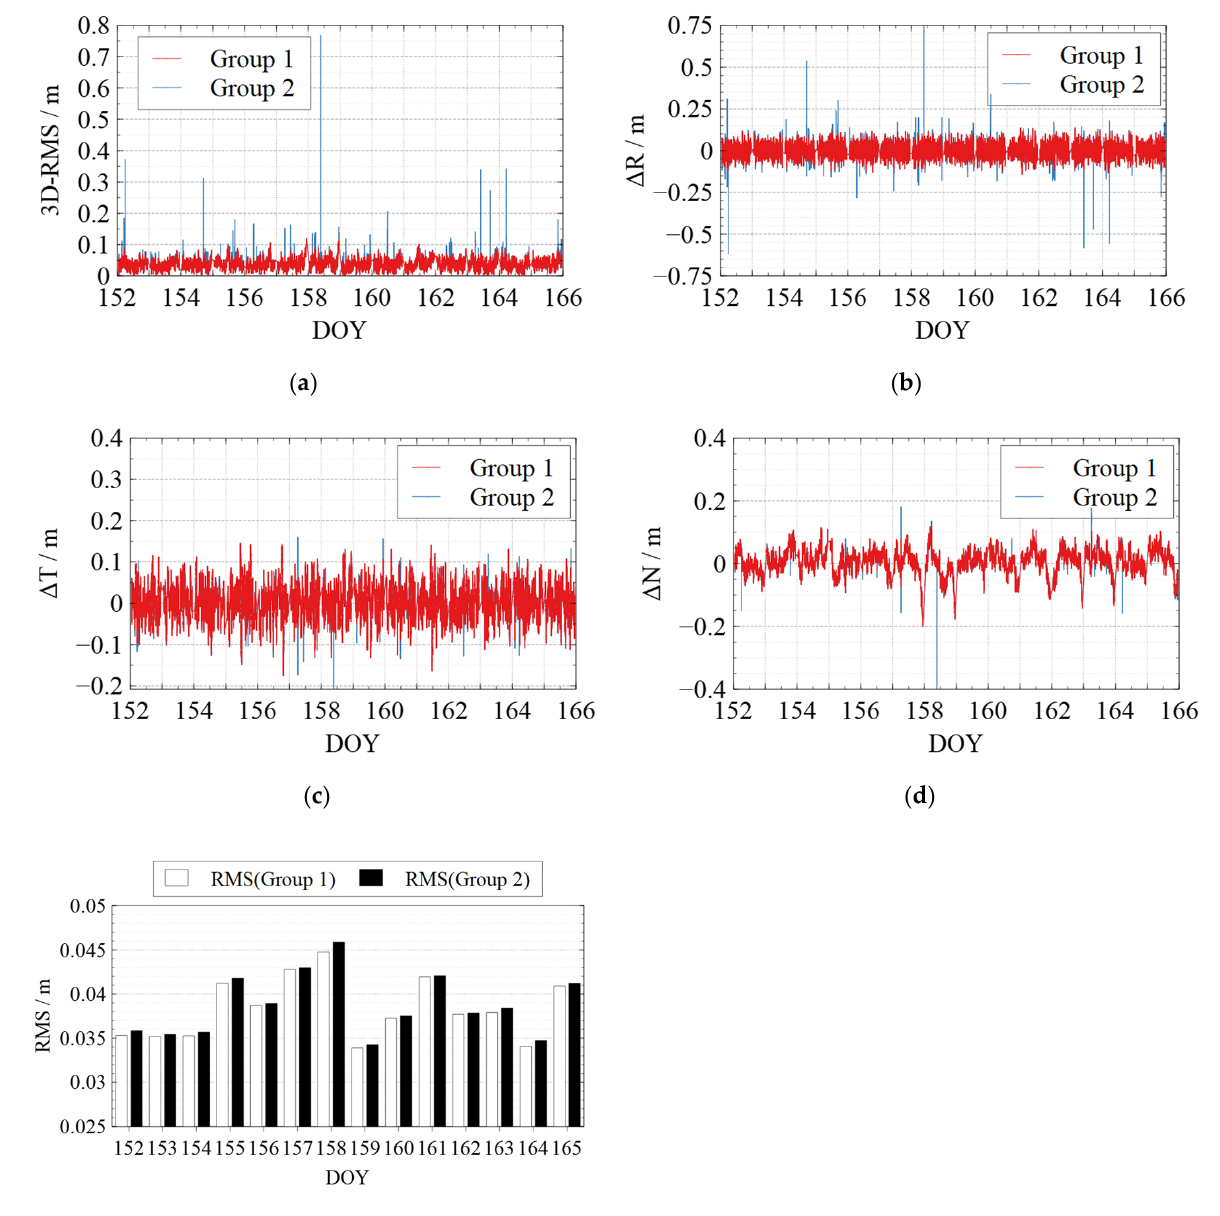
Figure 7. Comparison between the kinematic orbits of Swarm-B and the precise orbits provided by the ESA. ( a ) 3D-RMS of the comparison results; ( b ) Difference in Radial direction; ( c ) Difference in Tangent direction; ( d ) Difference in Normal direction; ( e ) Average 3D-RMS statistics of the comparison results. Where the red line shows the results of Group 1 while the blue line shows the results of Group 2 in ( a – d ). The white blocks and black blocks in ( e ) represent the RMS of Group 1 and Group 2 on each day, respectively.